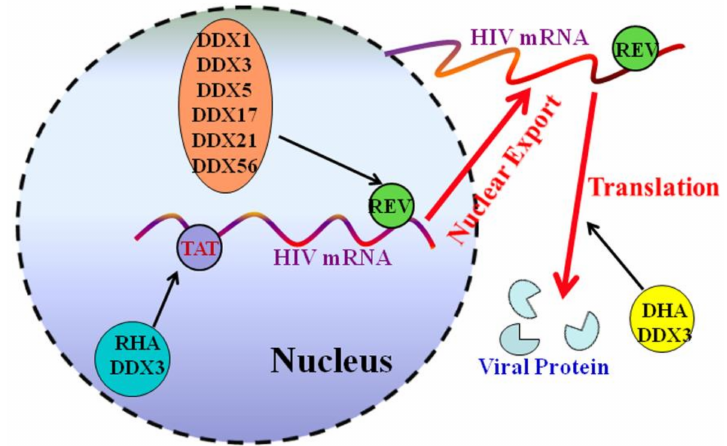
Figure 2. Role of DDX5 and other cellular helicases in the HIV-1 gene expression. DDX5 interacts with HIV Rev and participates in splicing or export of Rev-dependent mRNAs. Other cellular helicases with known functions are involved in HIV mRNA transcription, nuclear export, and